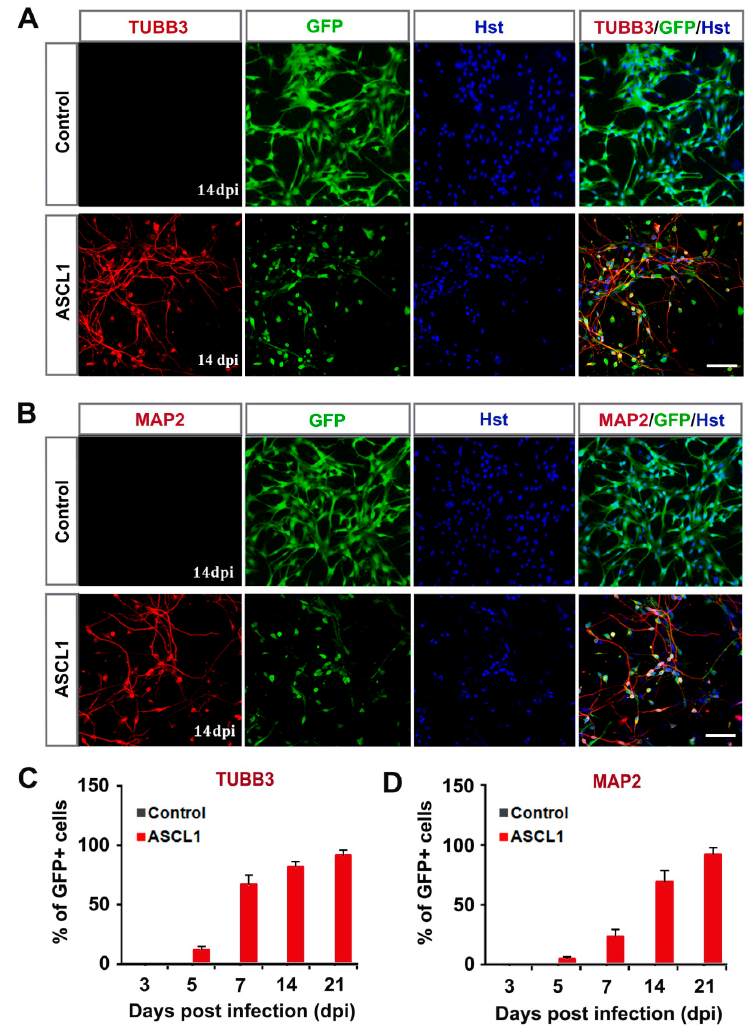
Figure 4. Time-course analysis of ASCL1-mediated neuronal reprogramming of human glioma cells. ( A , B ) Immunostaining of neuronal markers TUBB3 and MAP2 in ASCL1converted cells at 14 dpi. ( C , D ) Quantification of neuronal marker expressing in ASCL1-infected U251 cells during the indicated course (n = 20 random fields from triplicated samples). Scales: 100 µ m ( A , B